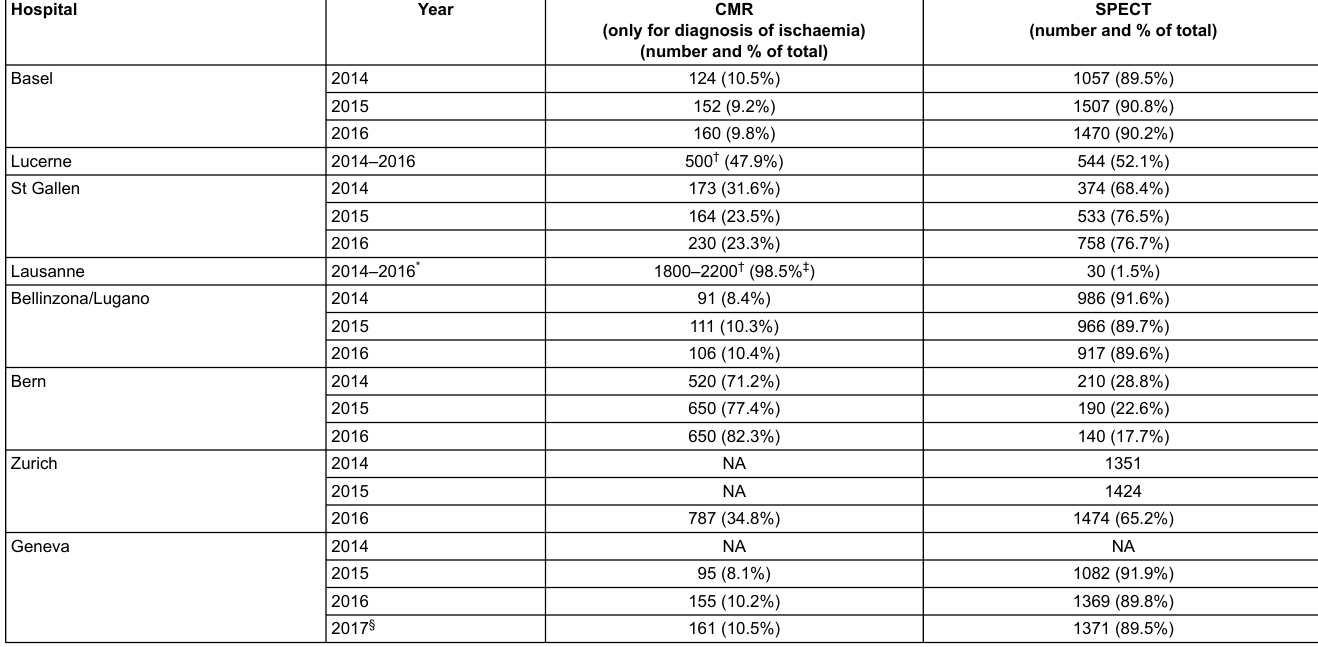
Table 1: Number of CMR and SPECT examinations conducted between 2014 and 2016 in the Swiss structures where both technologies are available. Hospital CMR